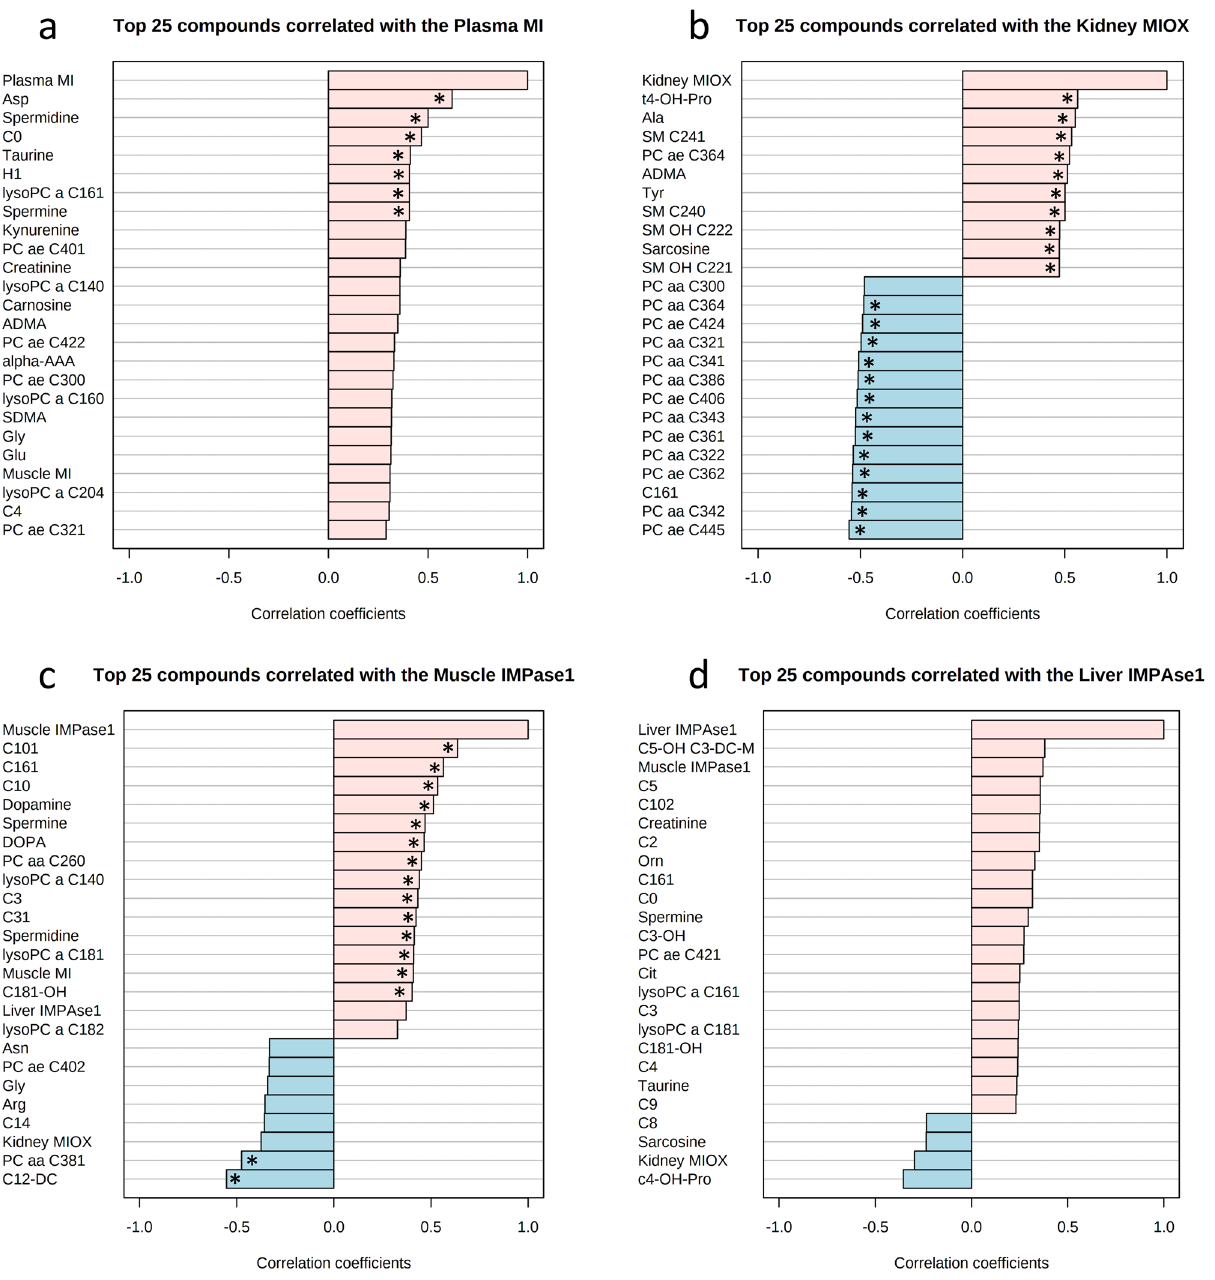
Figure 4. Pearson’s correlations using pattern search function in MetaboAnalyst 4.0 between components of MI metabolism and plasma metabolites in all hens and all time points. ( a ) Correlation to plasma MI; ( b ) correlation to kidney myo -inositol oxygenase (MIOX); ( c ) correlation to muscle inositolmonophosphatase 1(IMPase 1); ( d ) correlation to liver IMPase 1. Correlations with Pearson’s correlation coefficient (r) ≥ 0.4 (*) were discussed in detail in the text; corresponding statistical information is provided in Supplementary Table S1. Ala alanine, Alpha-AAA alpha-aminoadipic acid, Arg arginine, Asn asparagine, Asp aspartate, C0 carnitine, ADMA asymmetric dimethylarginine, Ala alanine, C3 propionylcarnitine, C3:1 propenoylcarnitine, C4 butyrylcarnitine, C10 decanoylcarnitine, C10:1 decenoylcarnitine, C10:2 decadienylcarnitine, C12-DC dodecanedioylcarnitine, C14 tetradecanoylcarnitine, C16:1 hexadecenoylcarnitine, C18:1-OH hydroxyoctadecenoylcarnitine, DOPA dihydroxyphenylalanine, Gly glycine, Glu glutamate, H1 sum of hexoses, IMPase 1 myo -inositol monophosphatse 1, Lyso PC lysophosphatidylcholines, Met methionine, Met-SO Methionine sulfoxide, MI myo -inositol, MIOX myo -inositol oxygenase, PC phosphatidylcholine, SDMA symmetric dimethylarginine, SM sphingomyelins, t4-OH-Pro trans-4-hydroxyproline, Tyr